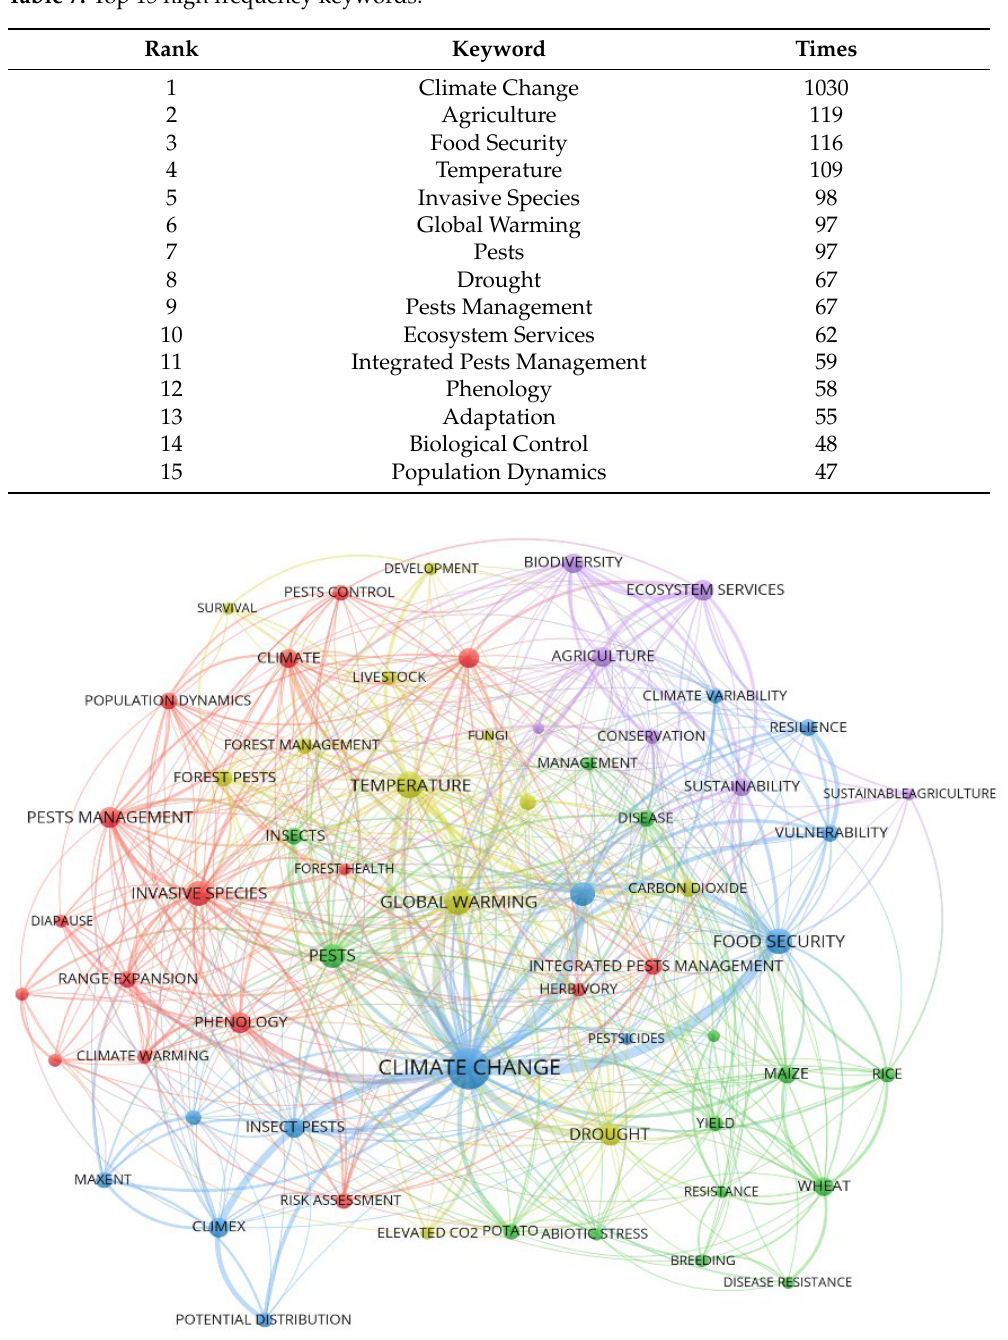
Table 7. Top 15 high frequency keywords.